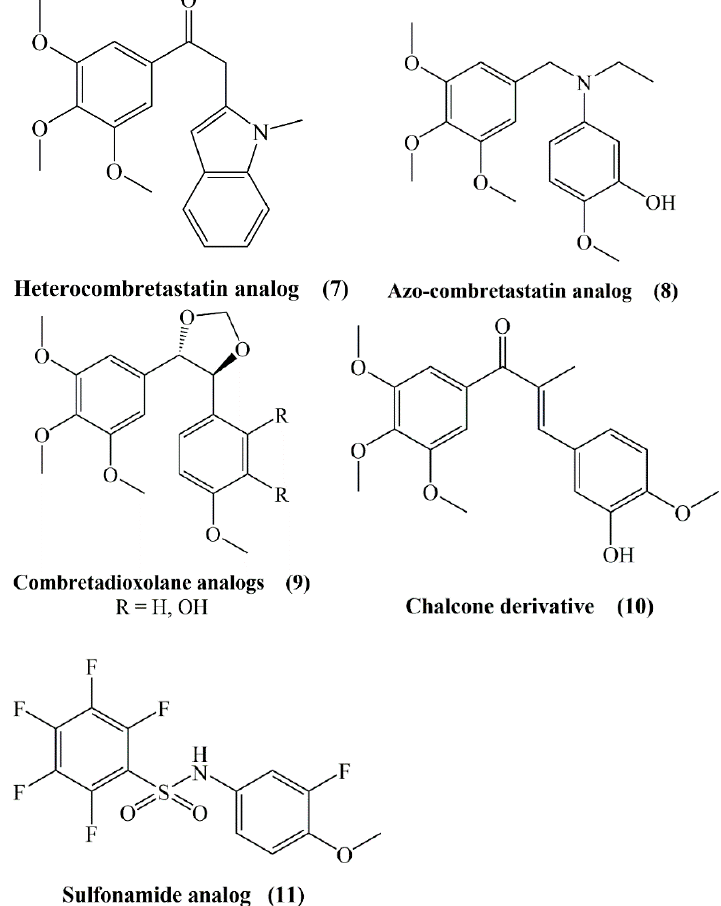
Figure 3. Structures of heterocombretastatin, azo-combretastatin, combretadioxolane analogs, chalcone derivatives and sulfonamide analogs.